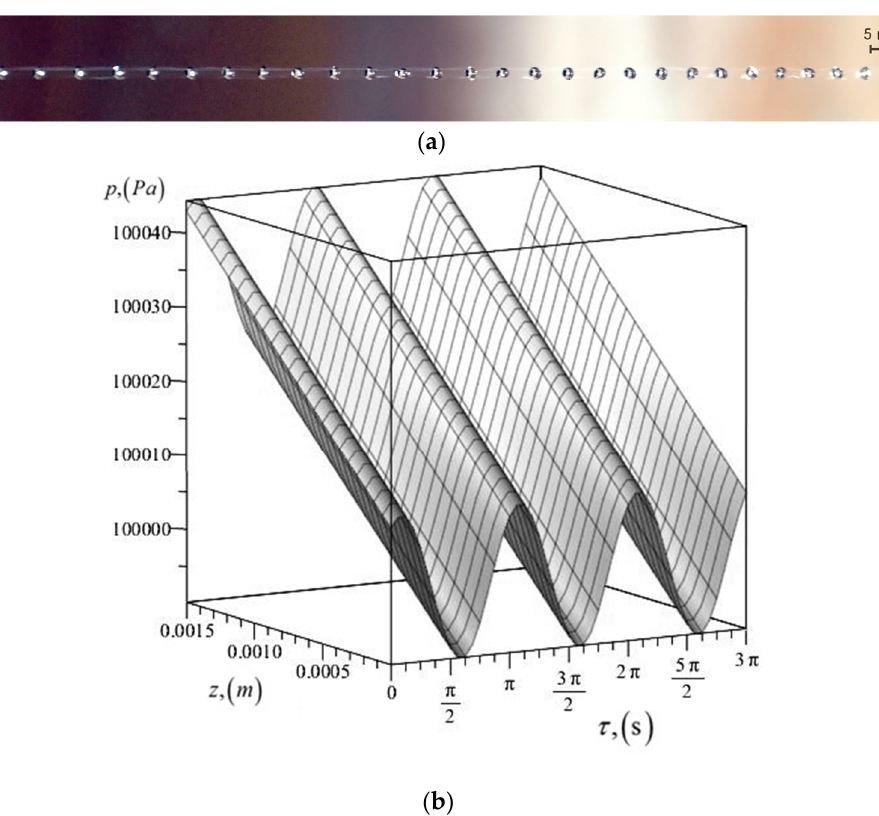
Figure 3. Study results of the jet at a signal frequency of 380 Hz, and amplitude of 100 μ m: ( a ) physical experiment; ( b ) theoretical calculation using Equation (8).